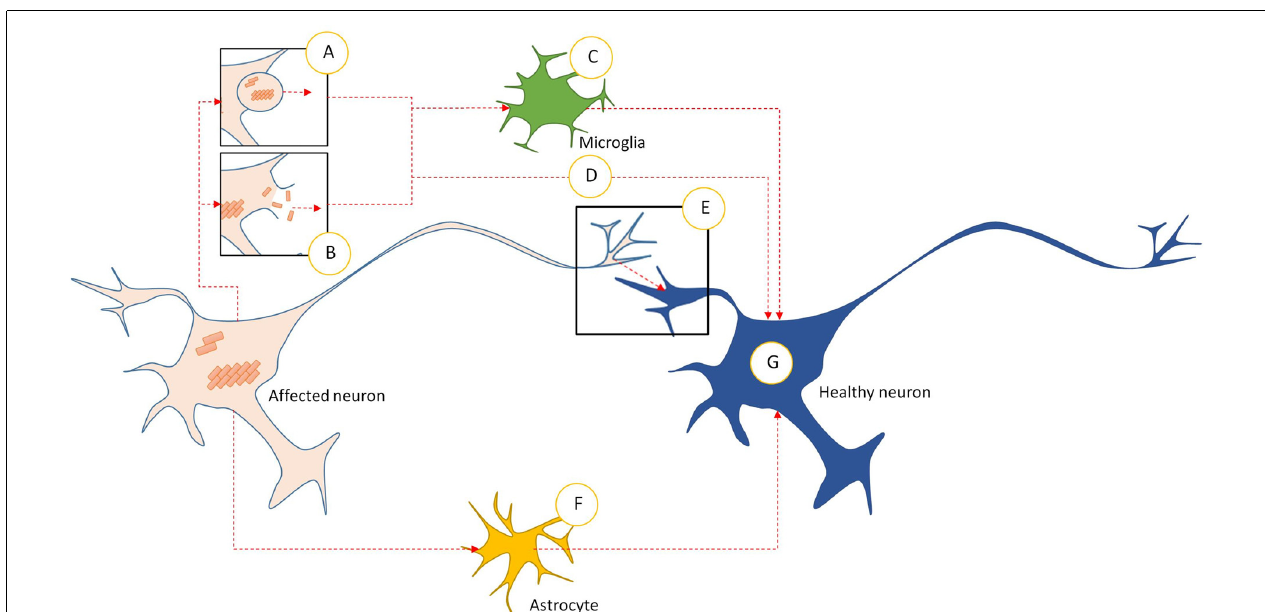
FIGURE 2 | Intercellular transmission pathways in prionoid NDs. (A) Prionoid aggregates and oligomers are released into the extracellular space through exocytosis. This can occur in normal cells, but may be accelerated during pathology. (B) Cell death releases aggregates and oligomers developing within the affected neuron. Some of these are capable of persisting in the extracellular space. (C) Microglia phagocytose extracellular aggregates and oligomers. Many pathological processes weaken enzymatic degradation processes, allowing engulfed prionoid material to persist. Some prionoids may be released, either in vesicles or following death of the microglia, facilitating infection of neighboring cells. (D) Extracellular aggregates and oligomers can be taken into healthy neurons by unconfirmed processes. These include endocytosis, micropinocytosis and protein-mediated uptake. (E) Prionoid material can be transmitted directly across synapses. Alternatively, tunneling nanotubes may facilitate direct transmission between neurons. (F) Prionoid material can be internalized by astrocytes, possibly at the synapse or through tunneling nanotubules. Aggregation can progress within the astrocytes, or prionoid material can be transferred to healthy neurons through tunneling nanotubes. (G) Once prionoid material has entered a healthy neuron, it can seed pathological aggregation. Aggregates may seed conformational changes in natively conformed proteins, while oligomers may either accelerate the growth of seeded aggregates or infect functional amyloid